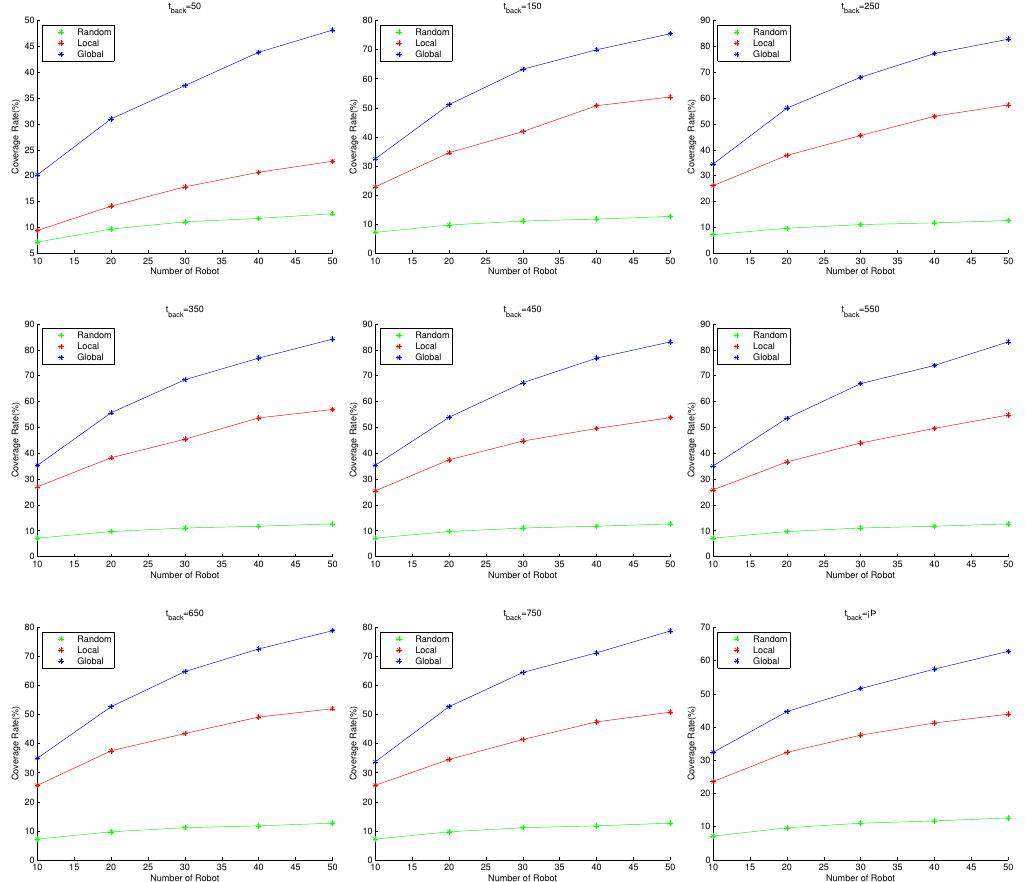
Figure 6. Comparison of performance for f global , f local and f random . In each subfigure, t back is set with the same value, and swarms with 10, 20, 30, 40, 50 robots are tested with all three behavior laws. The performance of the control law is evaluated with coverage rate. From each subfigure, we notice that, for a fixed number of robots, no matter how t back is set, the performance of f global is always superior to that of f local . Both the f global and f local schemes perform better than f random . In addition, with the increase of swarm size, the performance also increases no matter which scheme is adopted. However, the increase of performance is obvious for f local and f global , while that for f random is rather insignificant. This trend appears in each subfigure, which implies that f global is superior to f local and f random no matter how t back is